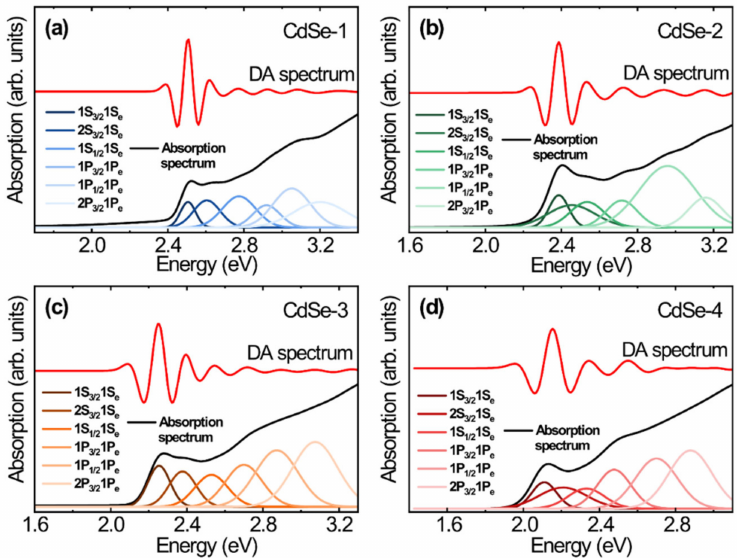
Figure 4. Absorption (black) and di ff erential absorption spectra (red) of ( a ) CdSe–1, ( b ) CdSe–2, ( c ) CdSe–3, and ( d ) CdSe–4 with first through sixth excitonic transitions extracted from di ff erential absorption (DA) spectroscopy